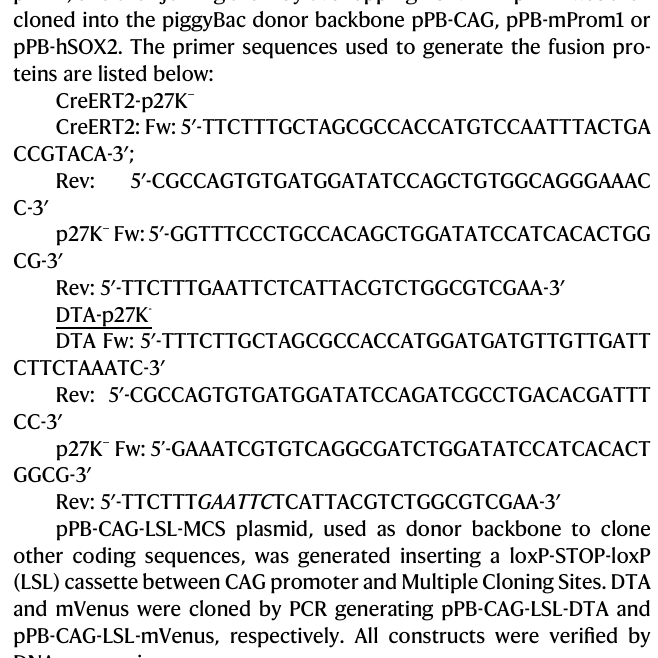
Fig. 5 | Direct visualization and targeting of in fi ltrating quiescent cells